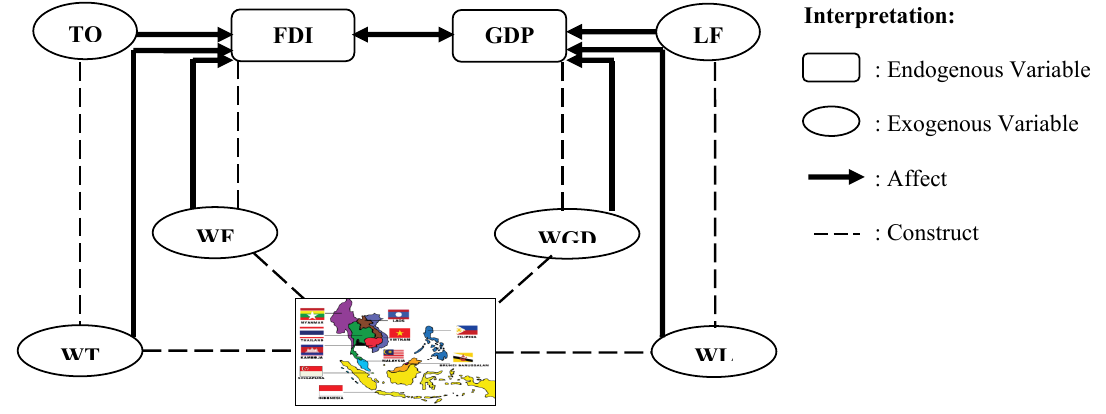
Fig. 1. Research Variable Relationships